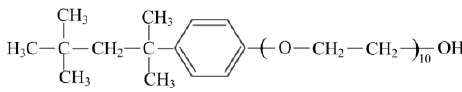
Figure 1. Chemical structure of surfactant Triton X-100.